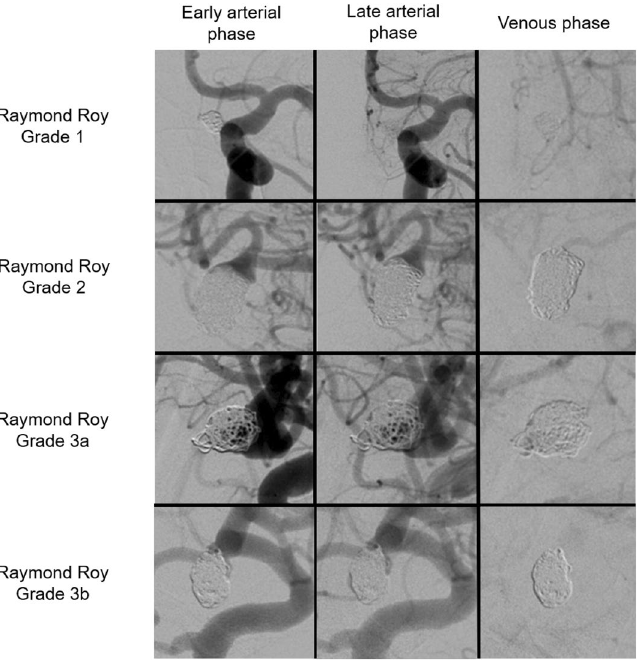
Figure 4. Angiograms of different outcomes in the Raymond Roy grading scale immediately after conventional aneurysm